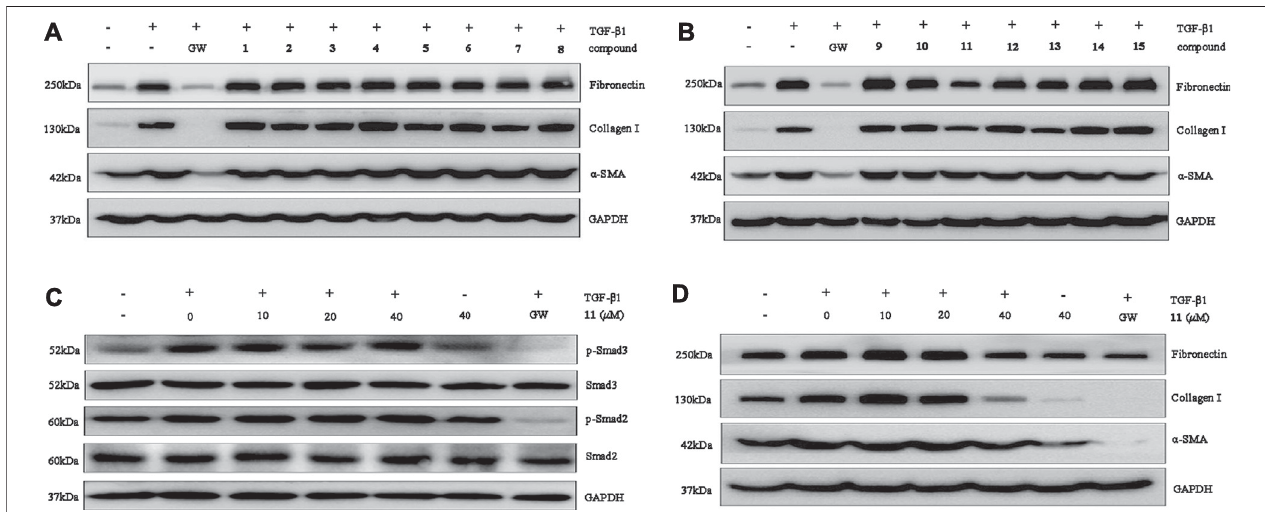
FIGURE 6 | Compounds 1 – 15 inhibit renal fi brosis in vitro . (A,B) : Protein expression of collagen I, fi bronectin, and α -SMA was examined by Western blot analysis. (C) : Compound 11 at 0 μ M, 10 μ M, 20 μ M, and 40 μ M affected TGF- β 1-induced Smad phosphorylation. GAPDH was used as an internal control. Three independent experiments were performed. (D) : Compound 11 dose-dependently inhibits fi bronectin and collagen I expression. GAPDH was used as an internal control. GW was used as a positive control. GW: GW788388. Three independent experiments were